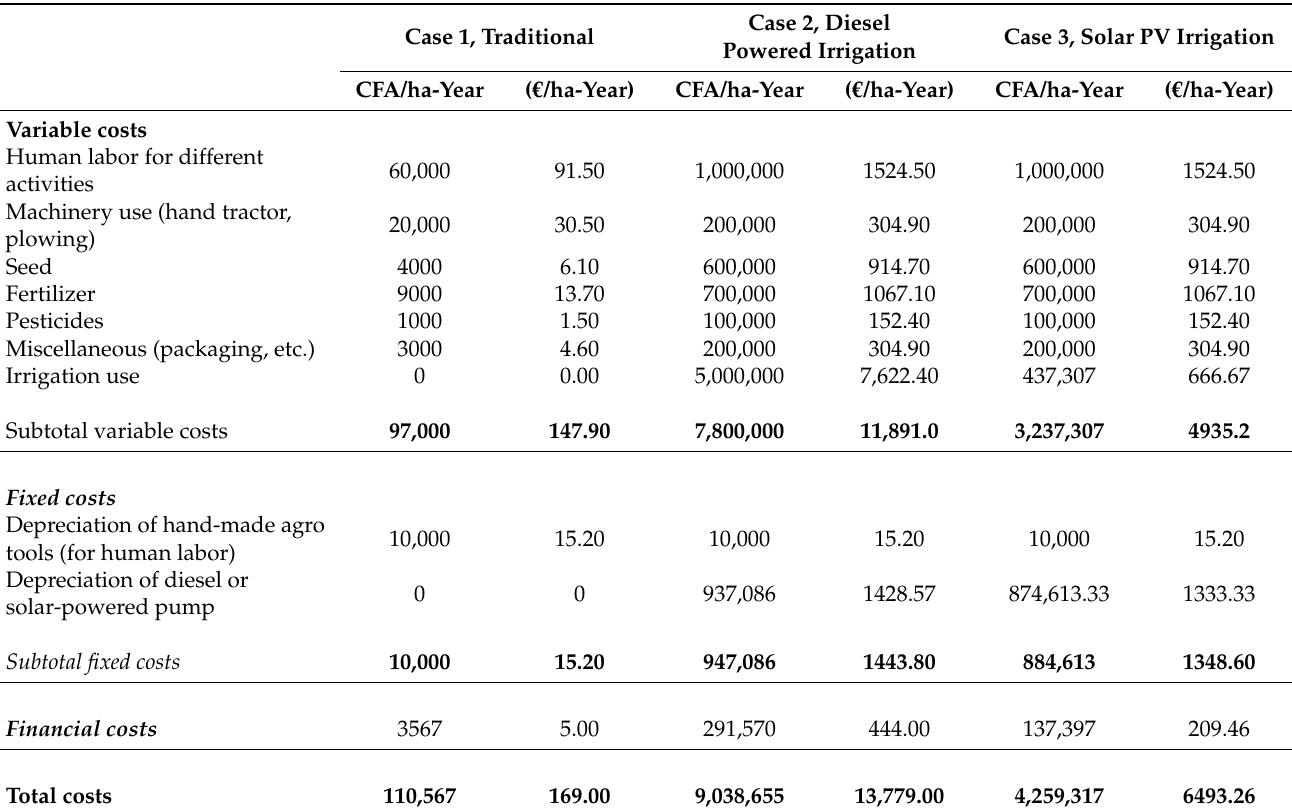
Table 2. Farming cost distribution, cases 1–3 [14,43].